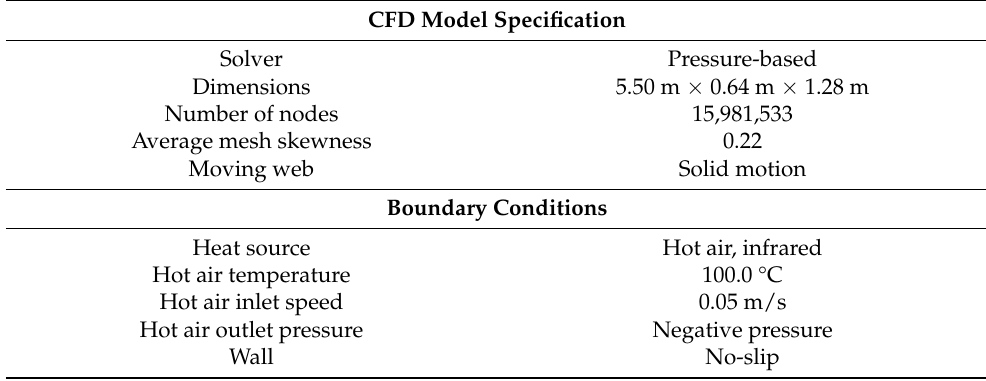
Figure 3. Mechanical and thermal properties of PET film by substrate temperature: ( a ) Elastic modulus; ( b ) coefficient of thermal expansion (CTE). Table 2. Computational Fluid Dynamics (CFD) dryer model specification and boundary conditions of dryer system.